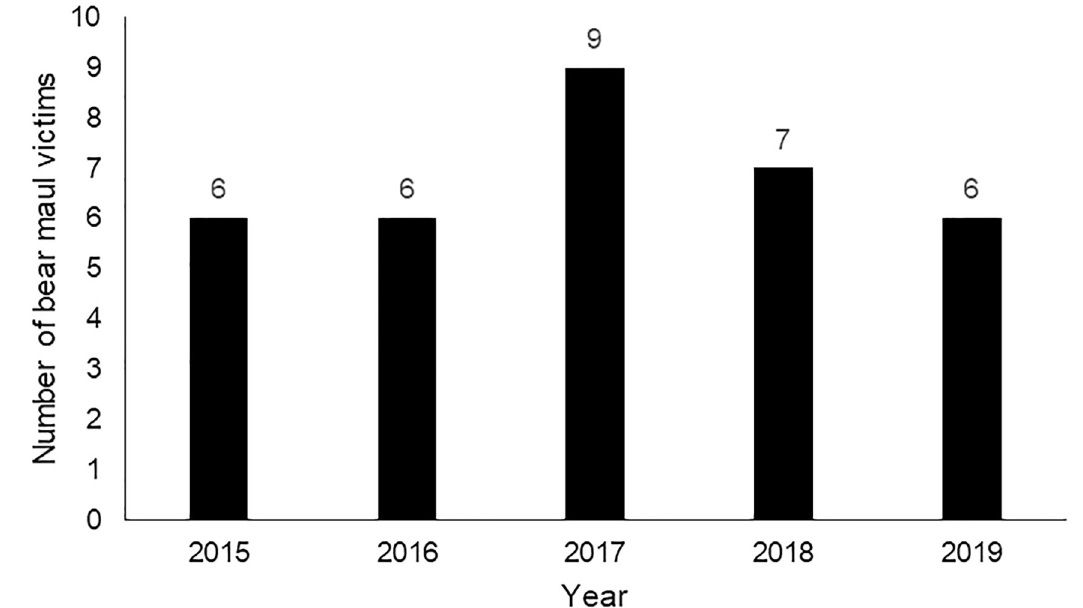
Fig 1. The distribution of victims of bear attacks by years who received care at the Jigme Dorji Wangchuck National Referral Hospital, Bhutan during the period 2015–2019.